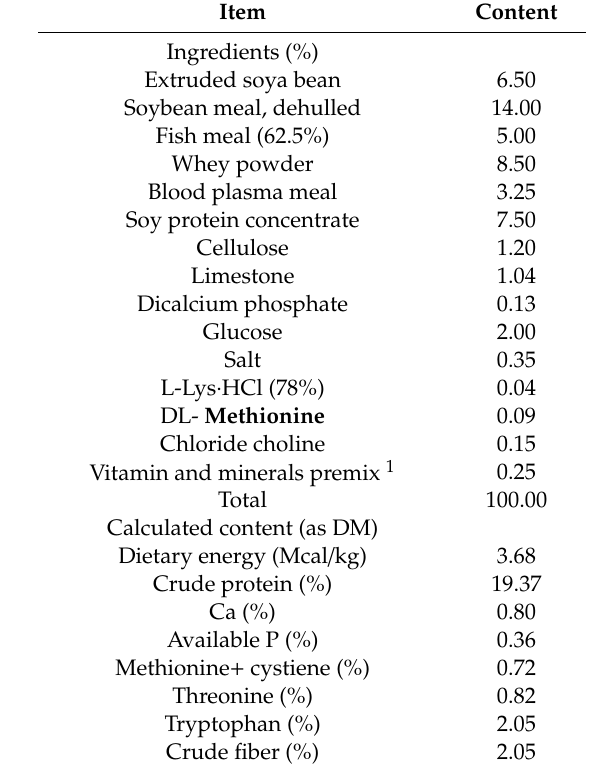
Table 1. Ingredients and chemical composition of experimental diets (as-fed basis).